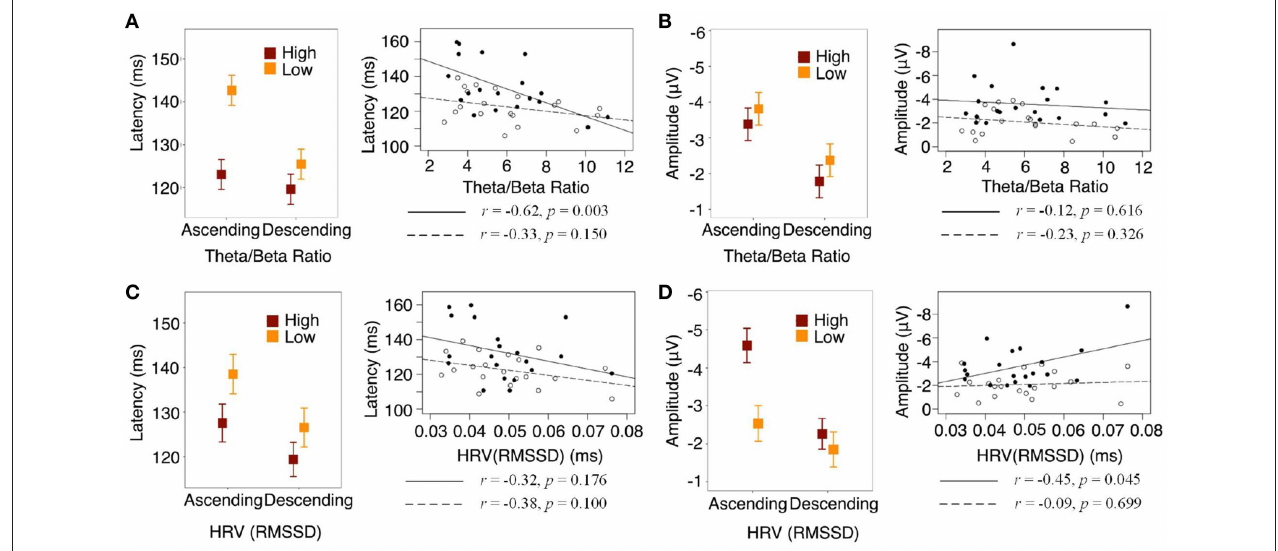
FIGURE 2 | Contextual effect interacted with self-regulation. Solid lines and dots represent ascending condition, dash lines and circles represent descending condition. (A) Statistical interaction modeling showed that theta/beta ratio interacted with context on MMN latency, χ 2 (1) = 5.10, p = 0.0239. (B) Theta/beta ratio did not interact with context on MMN amplitude, χ 2 (1) = 0.04, p = 0.8448. (C) HRV did not interact with context on MMN latency, χ 2 (1) = 0.24, p = 0.6234. (D) HRV marginally interacted with context on MMN amplitude, χ 2 (1) = 3.67, p =